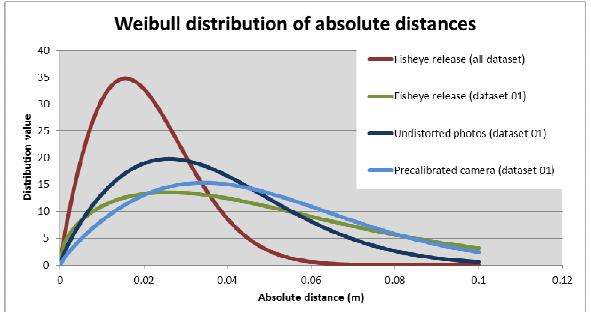
Figure 27: Weibull distribution of absolute distances. Comparison between integrated model and other ones made from dataset 01.